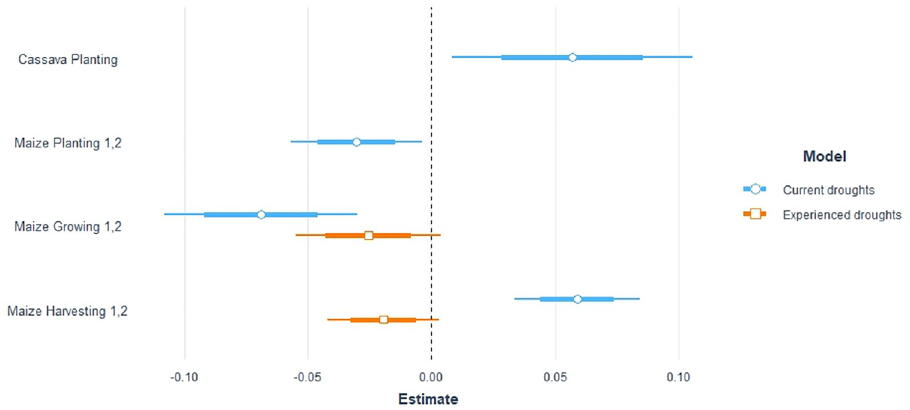
Fig 3. Deforestation and current droughts; graphical representation of deforestation in response to experienced and current droughts.